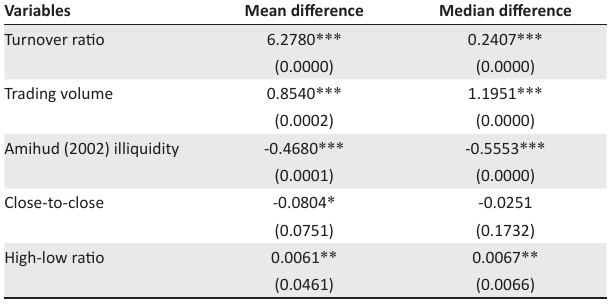
TABLE 2: Changes in liquidity and volatility after event date – Matched